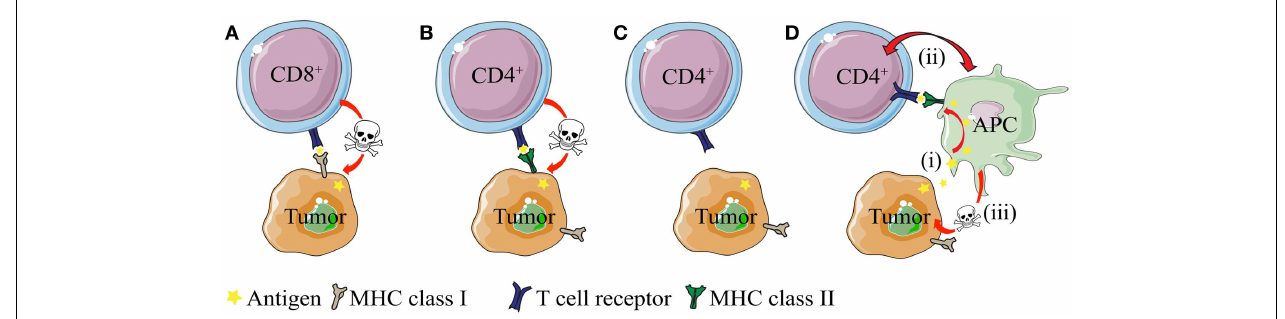
MHC class II negative (MHC II NEG ) tumors by a mechanism where (i) tumor antigen secreted by tumor cells is processed and presented by MHCII POS macrophages to CD4 + T cells. (ii) Bi-directional interaction/activation of macrophages and CD4 + T cells (iii) activates tumoricidal macrophages that in turn kill the tumor cells (In addition, activated CD4 + T cells themselves could possibly directly kill tumor cell in aTCR/MHC II-independent